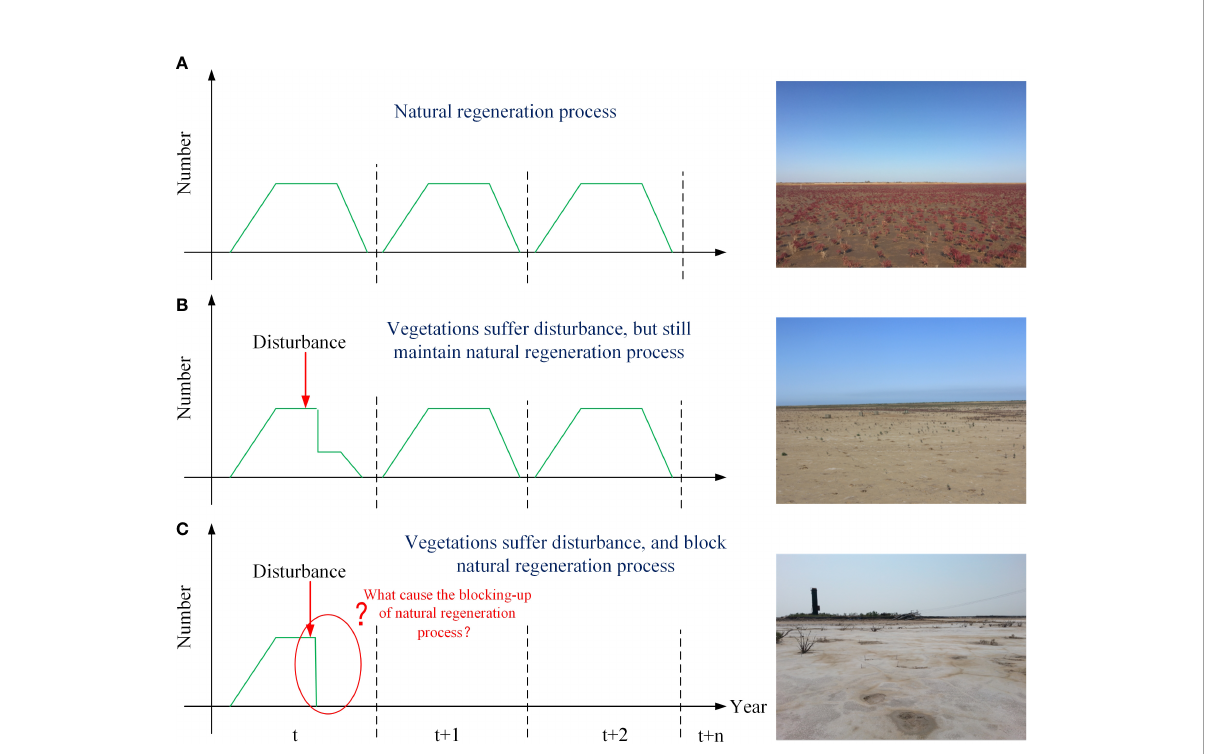
FIGURE 1 Modes of disturbance during the natural regeneration process for annual plants. (A) Natural regeneration process: a photograph of a natural saltmarsh. (B) Vegetation that has suffered from disturbance, but can still regenerate: a photograph of naturally recovering areas. (C) Vegetation that has suffered from disturbance and where the natural regeneration process has been blocked. The photograph shows a degraded area that remained bare over a number of